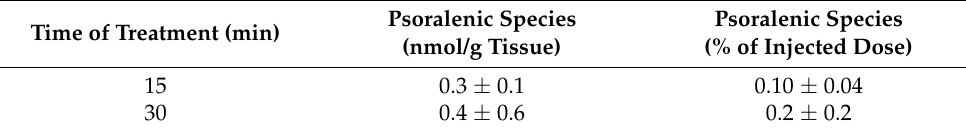
Table 1. Brain levels of PAPTPL in An2-PAPTP treated mice. Quantifications refer to the amount of PAPTPL extracted from brains after hydrolysis of the carbamate bond, corresponding to the amount of An2-PAPTP or its fragments. Data in the table are expressed as mean ± SEM ( n = 5 and 4, respectively).